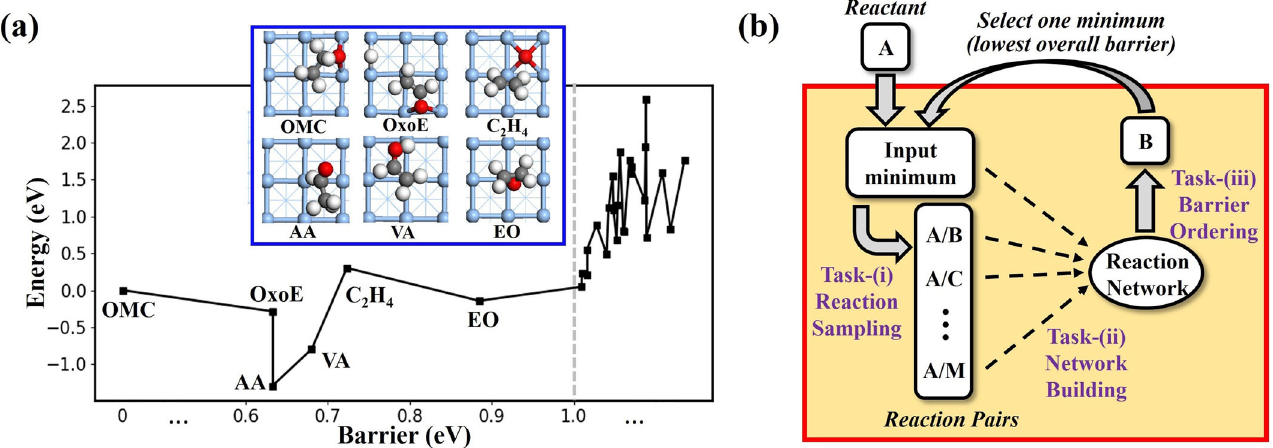
Fig. 4 The SSW-RS method and its application. a The barrier-energy map of the sampled products of oxometallacycle (OMC) intermediate on p(4 × 4) supercell of Ag(100) after 10000-step SSW-RS. Abbreviations: OxoE, 2-oxoethyl; AA, acetaldehyde; VA, vinyl alcohol; EO, ethene oxide. b The diagram of the general SSW-RS based pathway sampling algorithm, reproduced with permission from ref. 79 . Copyright American Chemical Society,